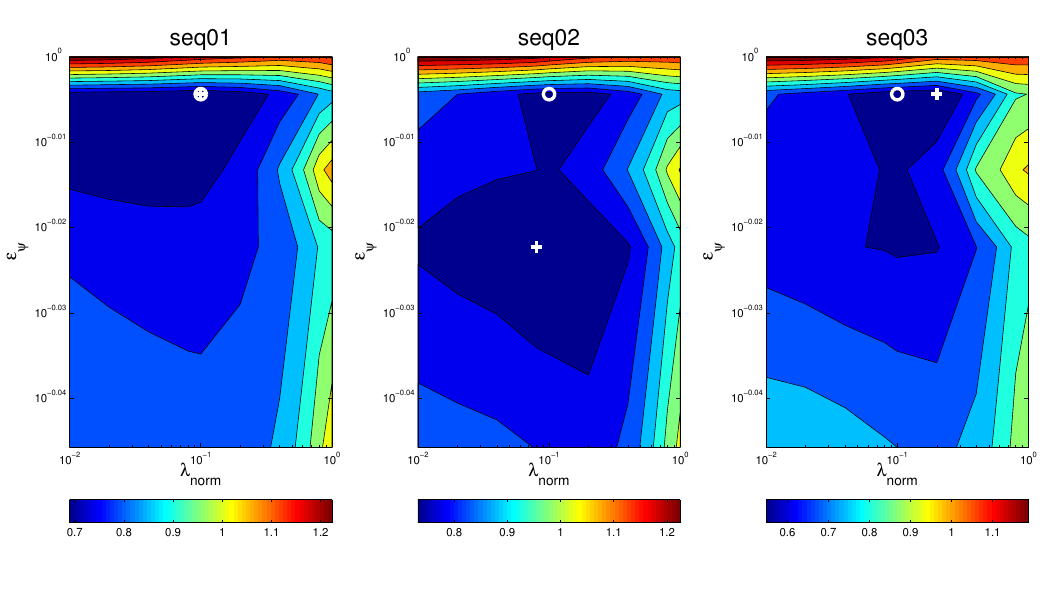
Figure 13. Optimization map for microphone setup A on all sequences, evaluating MOT P and frame size 160 ms.